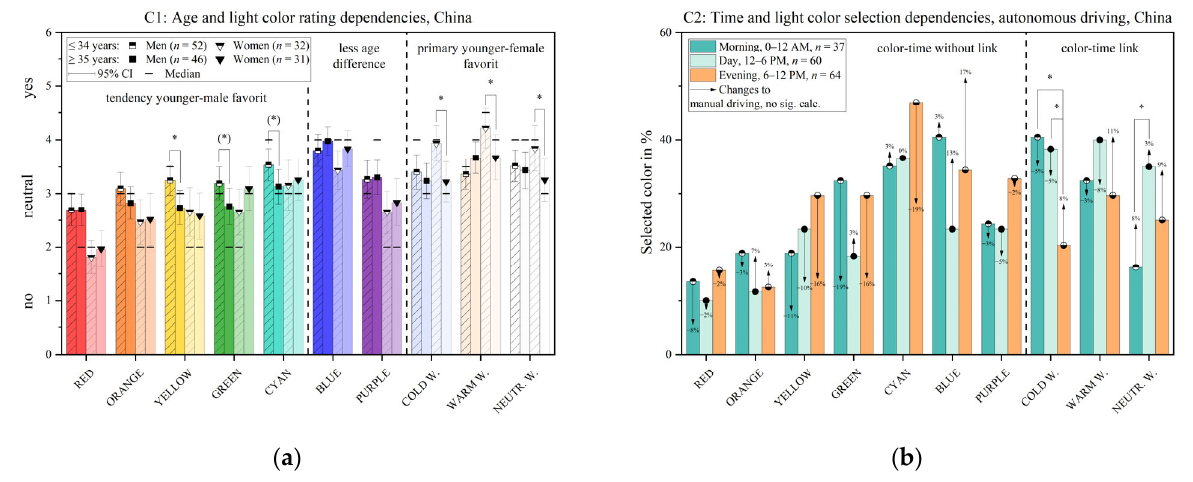
Figure 11. Within the Chinese participants only: ( a ) age and light color preferences; ( b ) time of the day and color selection dependencies; including statistical evaluations with significances p < 0.05 marked with * or for p ≤ 0.06 marked with (*).